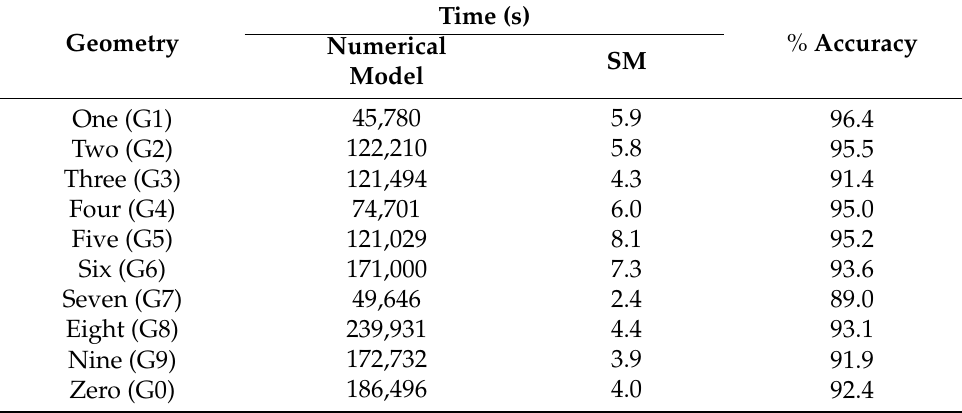
Table 3. Accuracy and speed of the surrogate